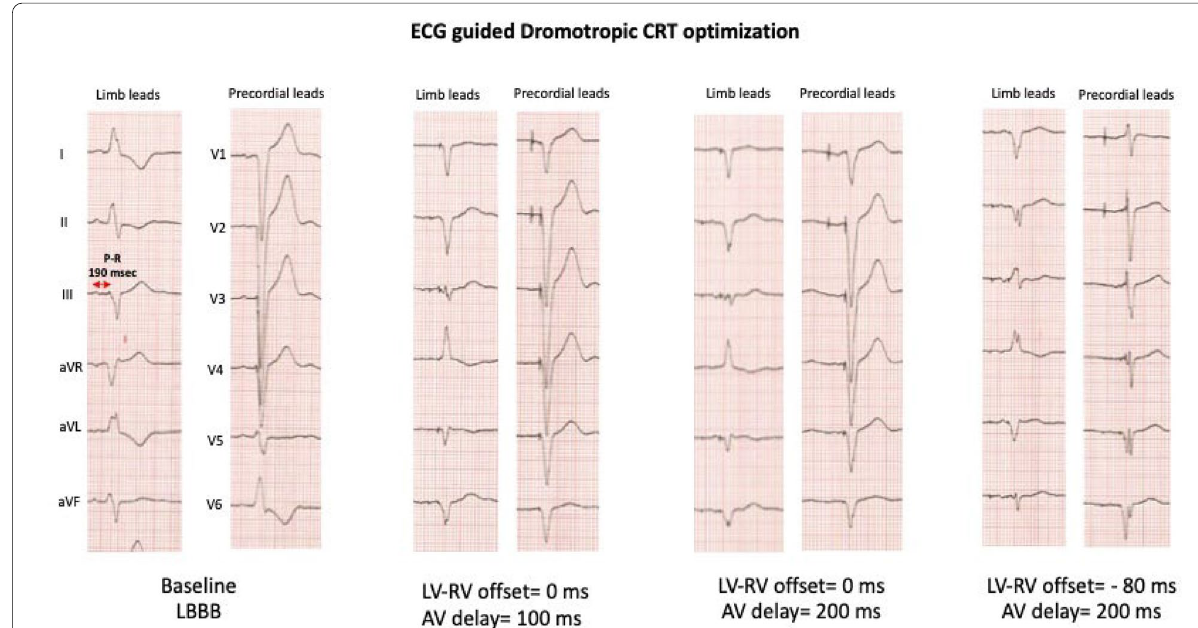
Fig. 2 “In-office” ECG dromotropic CRT optimisation. A case of nonischemic heart failure patient with a baseline LV ejection fraction of 22%, and a baseline ECG with LBBB with “Strauss criteria”, who underwent CRT-P implantation followed by routine post-implant ECG optimisation as shown. At 2-month follow-up, the LV ejection fraction raised up to 50%. From left, the first couples of standard 12 leads ECG tracings show the baseline pre-implant ECG with a typical (“Strauss”) LBBB pattern with intrinsic RV bundle conduction slightly longer but preserved, being a baseline PR interval 190 ms. The second and third couples of ECG tracing AV delay settings show the sequential AV delay programming (summarised the = shortest at 100 ms and the longest at 200 ms) to reach a RV sensing at a fixed simultaneous LV-RV offset ( 0 ms), in order to check for the RV sense = timing and promote fusion also for baseline longer intrinsic AV delays. In the fourth couple of ECG tracings, at the latest AV delay which induce detection of RV sense EGM by device telemetry, the LV offset is then programmed advancing the LV by the formula: sensed/paced A-RV interval minus the P-R interval derived by the baseline EC. LBBB left bundle branch block; LV left ventricle (pacing); RV right ventricle (pacing); offset VV delay programming with LV-RV which means LV pacing advances the RV